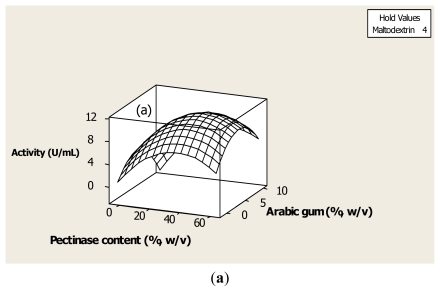
Response surface plots showing the significant (p < 0.05) interaction effects of encapsulation factors on enzymatic properties of pectinase. (a) Surface plot of pectinase activity versus Arabic gum, pectinase content (U/mL); (b) Surface plot of yield (%) versus maltodextrin and Arabic gum; (c) Surface plot of storage stability (%) versus maltodextrin and Arabic gum.